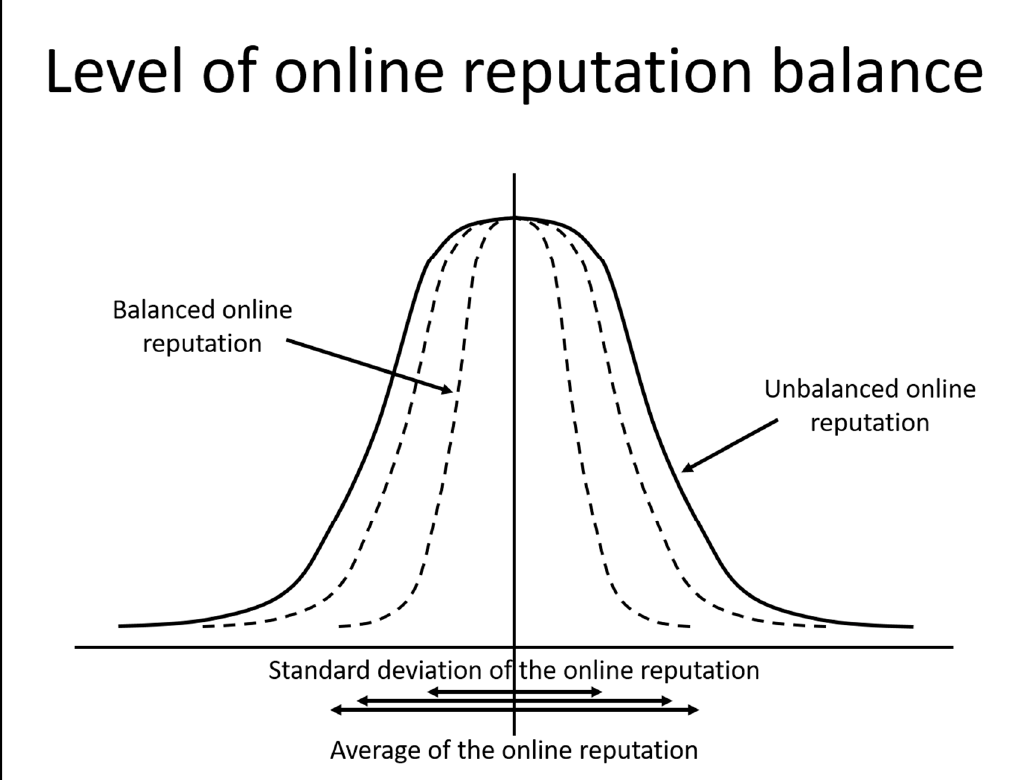
Figure 2. Level of balance of online reputation.